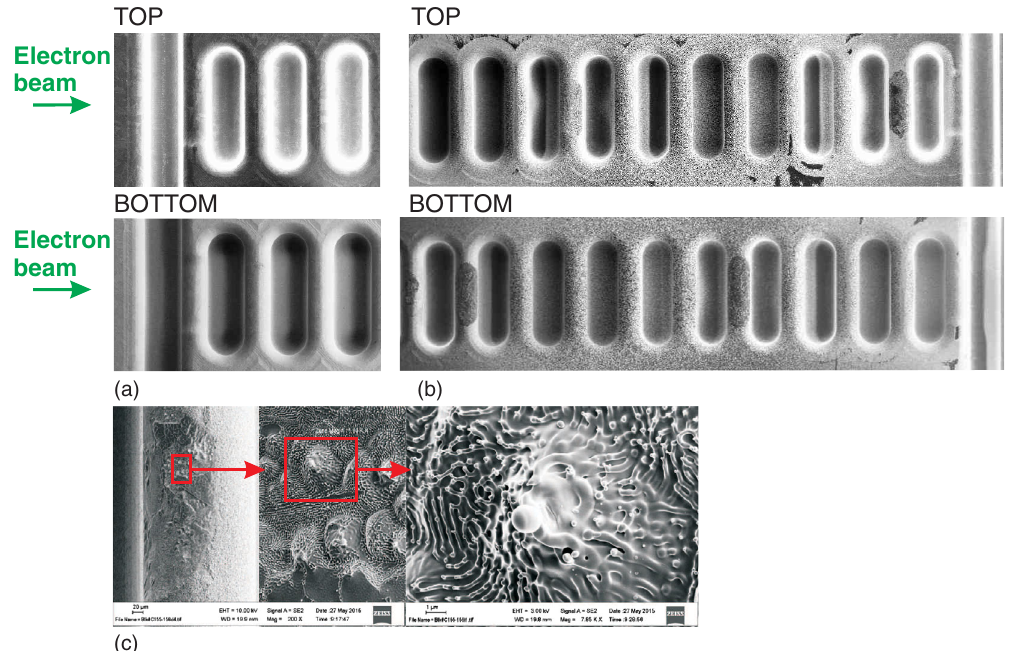
FIG. 25. SEM picture of breakdowns generated during the experiment involving the 235 GHz copper-silver structure, driven by a bunch charge of 1.6 nC and 25 μ m length. Input part of the structure: Little damage sign, from the input coupler to cell 149 (a). Output end of the structure: First areas of heavy arcing and surface melting occur after cell 155 (b); iris between cells 155 and 156, damage and surface melting